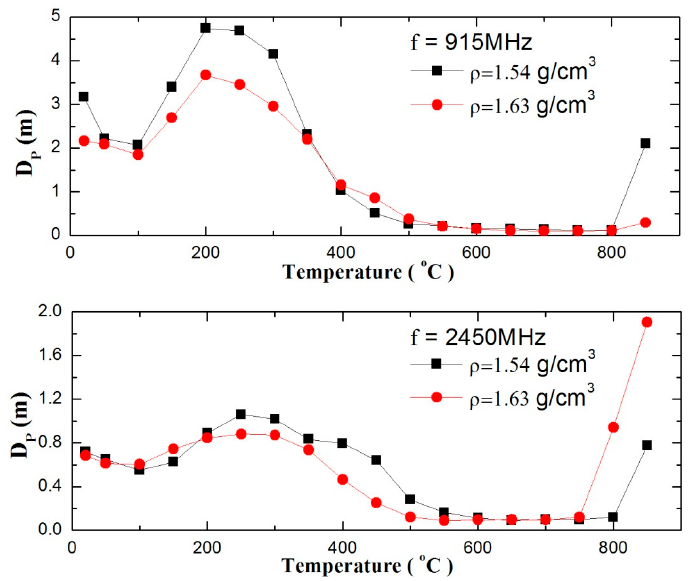
Figure 5. The variations of penetration depth of zinc sulfide concentrate with temperature.